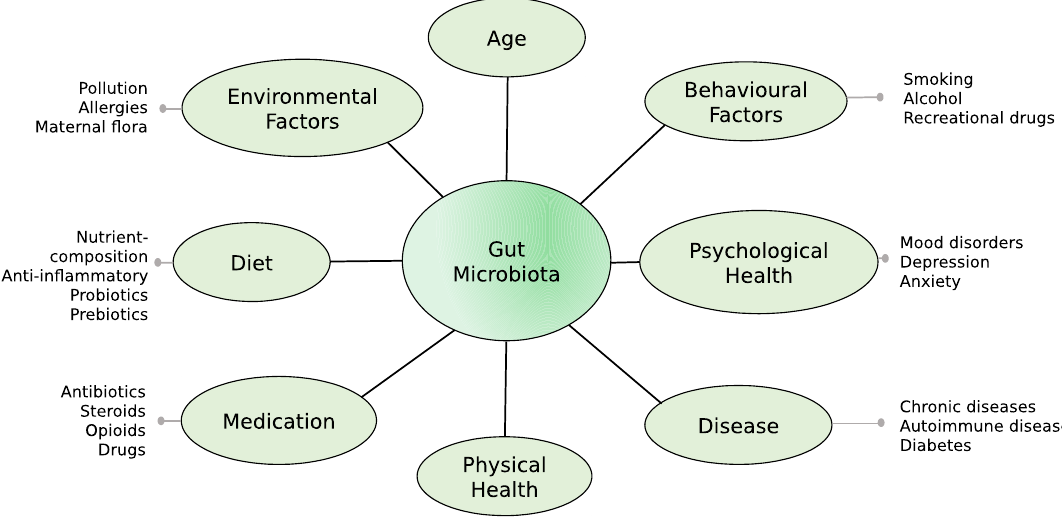
Figure 1. Factors a ff ecting the composition of gut